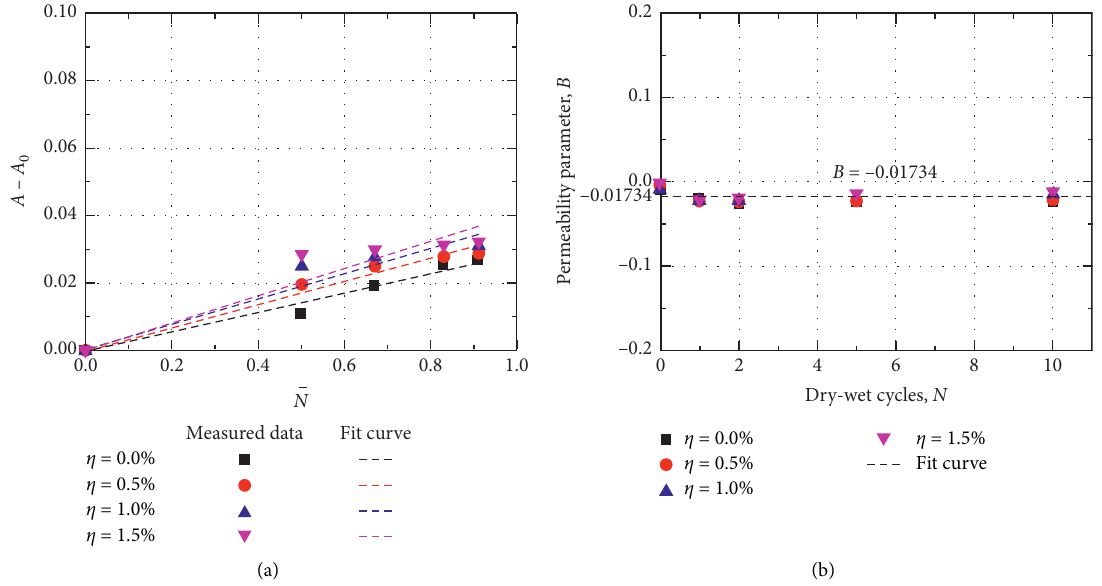
Figure 10: Fit results for parameters A and B . (a) Parameter A . (b) Parameter B.